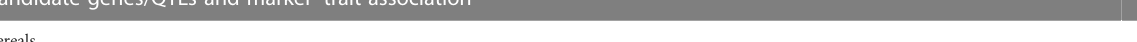
TABLE 5 Candidate genes/QTLs and marker – trait association (MTA) SNPs associated with increased grain Fe and Zn contents in cereal crops. Candidate genes/QTLs and marker – trait